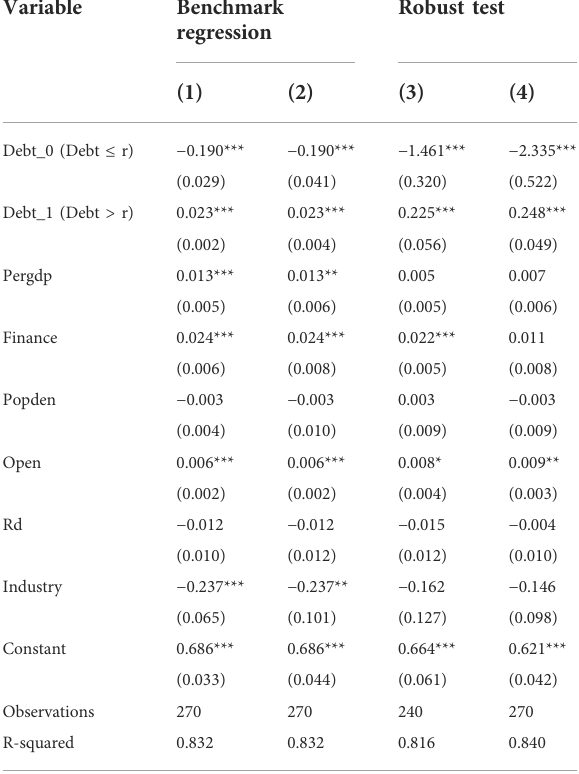
TABLE 8 Threshold regression results and its robustness test.